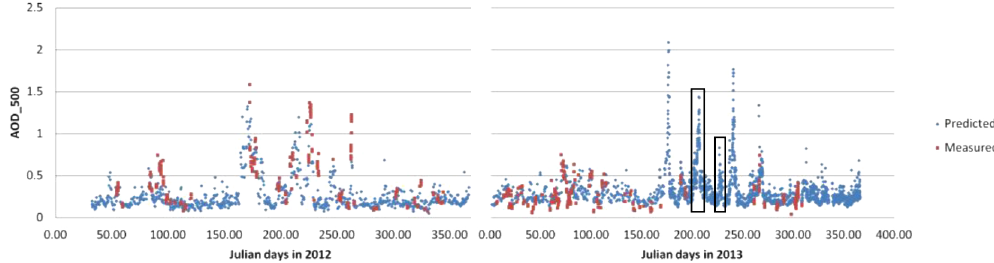
Figure 7. Predicted AOD_500 data plotted against the period from 2012 to 2013 (input all Vis and API available data into the established model to predict AOD, with 4493 data points). Rectangles 1 and 2 correspond to the data recorded on 24–25 July and 13–14 August 2013, respectively. These data were used for comparison with those obtained from LIDAR (Fig. 8). Table 5. R 2 values of the AOD predicted by selected linear regression models from the literature. The values of R 2 , RMSE and wMAPE shown in this table are obtained by comparing the predicted AOD values against measured AOD data from subset 1.